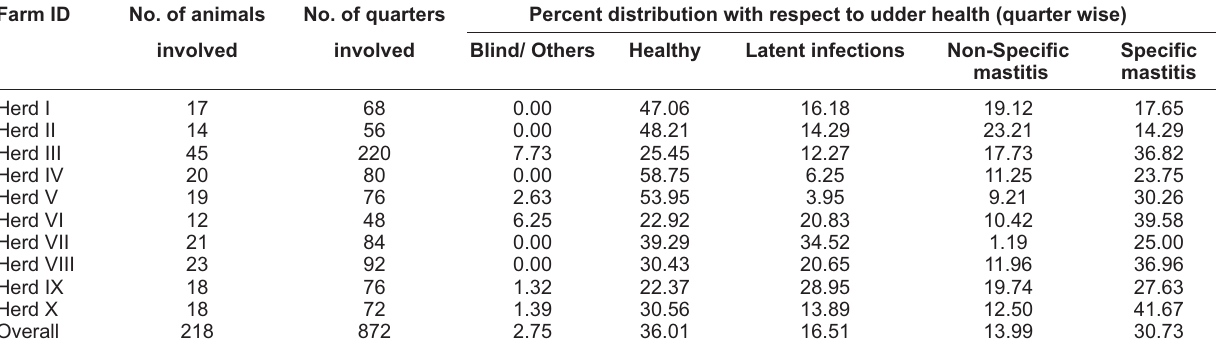
Table-2: Udder health status of dairy cows at various machine milked dairy farms Farm